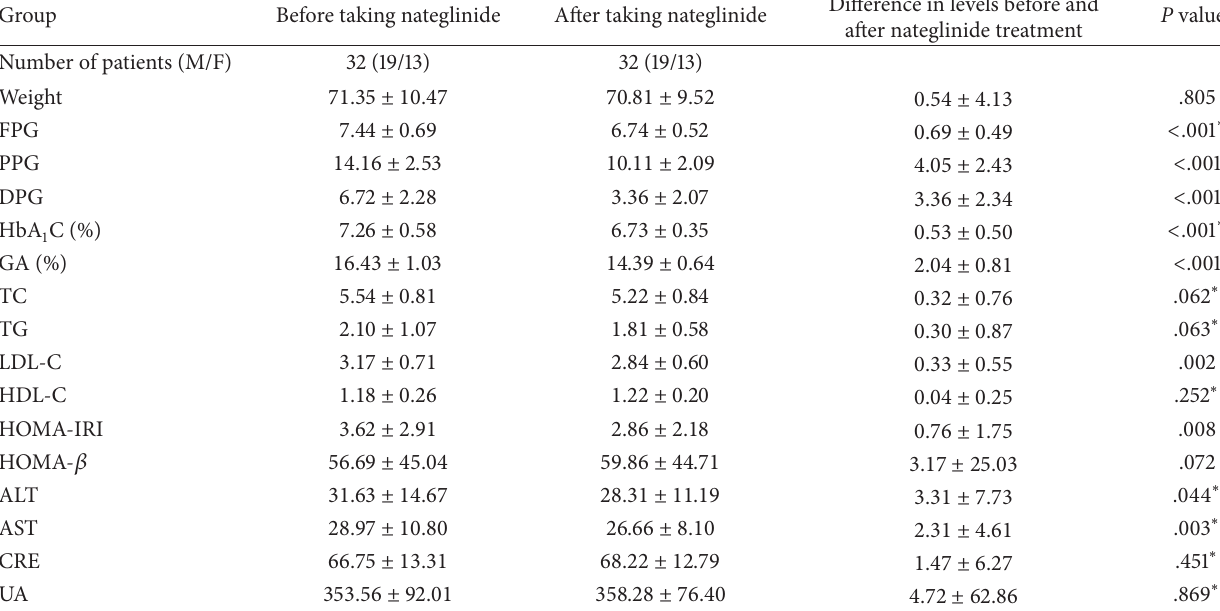
Difference in levels before and P values after nateglinide treatment